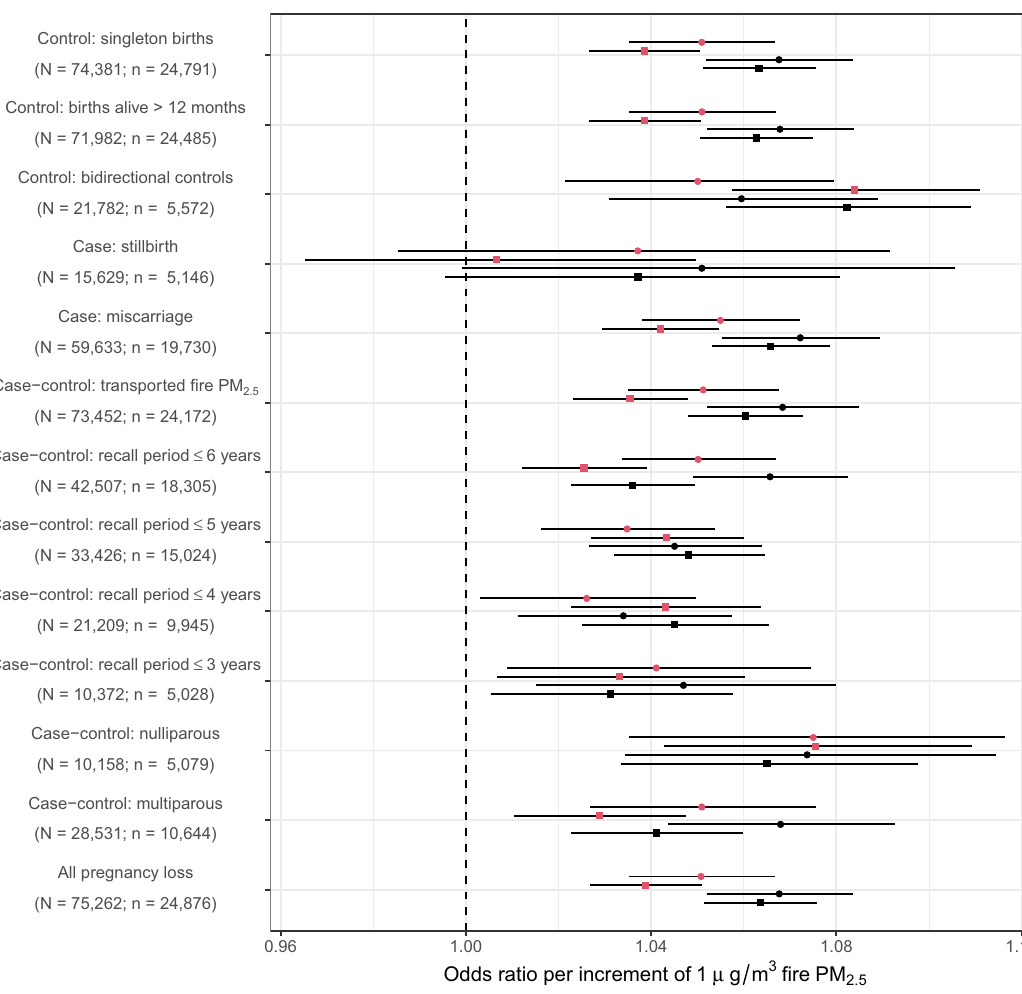
Fig. 3 Estimated associations between open fi re PM 2.5 and pregnancy loss for the selected subsets. Concentrations of fi re PM 2.5 were assessed by the GEOS-Chem model, and the associations were adjusted by maternal age, temperature, humidity, temporal trends, and non- fi re PM 2.5 . Along y -axis, “ n ” denotes the number of mothers, and “ N ” denotes the size of total samples (i.e., cases and controls). Each estimate is derived from an individual model of “ n ” independent pairs of cases and controls. The dots denote point-estimates of the associations, and the error bars denote the corresponding 95% con fi dence intervals. PM 2.5 particulate matter with a diameter of less than 2.5 µ